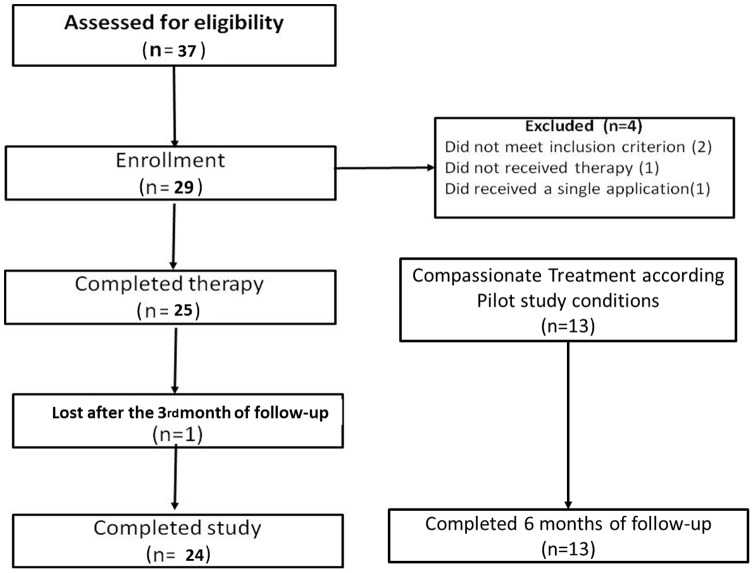
Study flow diagram.